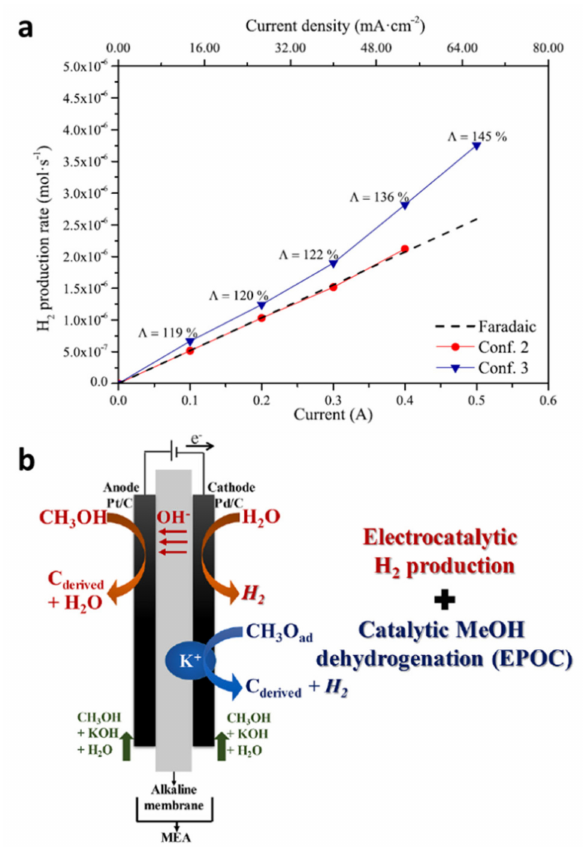
Figure 8. Steady-state H 2 production rate under di ff erent chronopotentiometries with a Pt-C / (Fumapem FAA-3-50) membrane / Pd-C electrolysis cell along with predicted faradaic H 2 production rate ( a ). Two operation modes: conventional electrolyser (conf. 2) where methanol is fed to the anode and water to the cathode, and EPOC-enhanced electrolyser (conf. 3) where methanol is also added in the cathode feed stream leading to additional catalytic H 2 production via electrochemical promotion. The later configuration is schematized in ( b ). Reprinted with permission from [134].